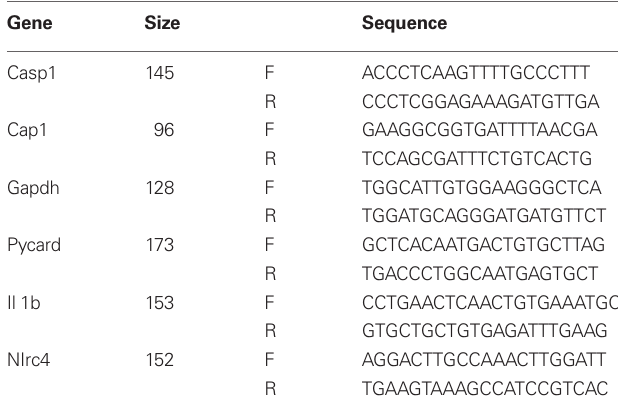
Table A1 | Mouse primers used in rT-PCr.